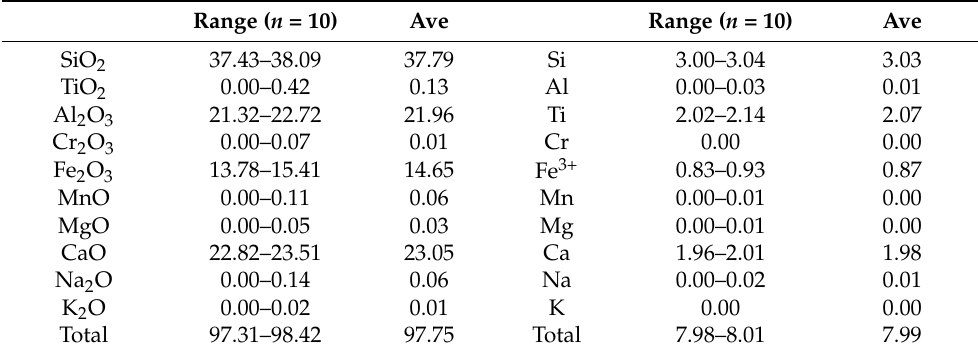
Figure 15. FeO vs. MgO diagram ( a ) and FeO vs. Al 2 O 3 diagram ( b ) for magnetites from the skarn and ore of the Jinling deposit. Table 6. EPMA data for epidote from Jinling skarn and ore.